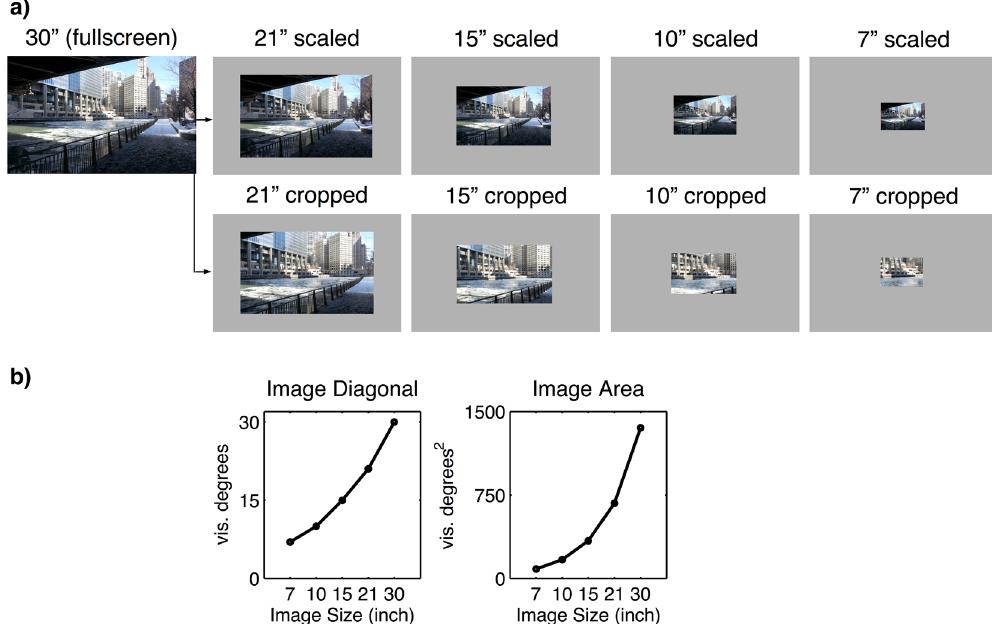
Figure 1. ( a ) Example of an urban image differing in size (scaled: upper row; cropped: lower row). ( b ) Visualization of the increase of image size from 7” to 30” (diagonal and